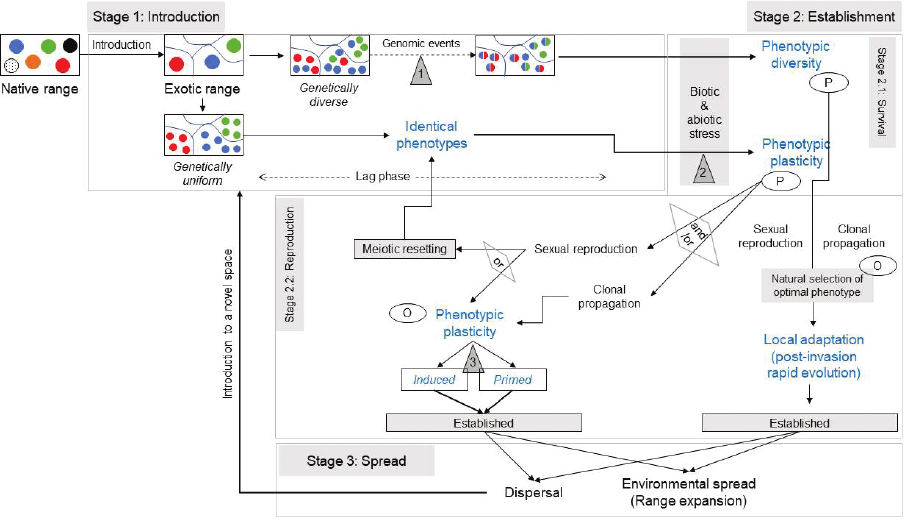
Figure 1. Conceptual framework for differentiating genetic and epigenetic basis for phenotypic vari- ations across three stages of alien plant invasion process (introduction, establishment, spread). While genetic differentiation between introduced populations may cause phenotypic variation which leads to local adaptation and post-invasion rapid evolution through selection of traits and natural selection of optimal phenotype across environmental conditions, epigenetically regulated phenotypic variations are more prevalent in genetically similar populations. Three sites where epigenetic mechanisms may influence invasion success have been marked with triangles: 1) in case of genetic admixture between different geno- types present in a region, 2) biotic and abiotic stress induced epigenetic alterations among the genetically similar populations, and 3) transmission of epigenetic information from the parents (P) to the offspring (O) making the progeny capable of dealing with similar kinds of parental